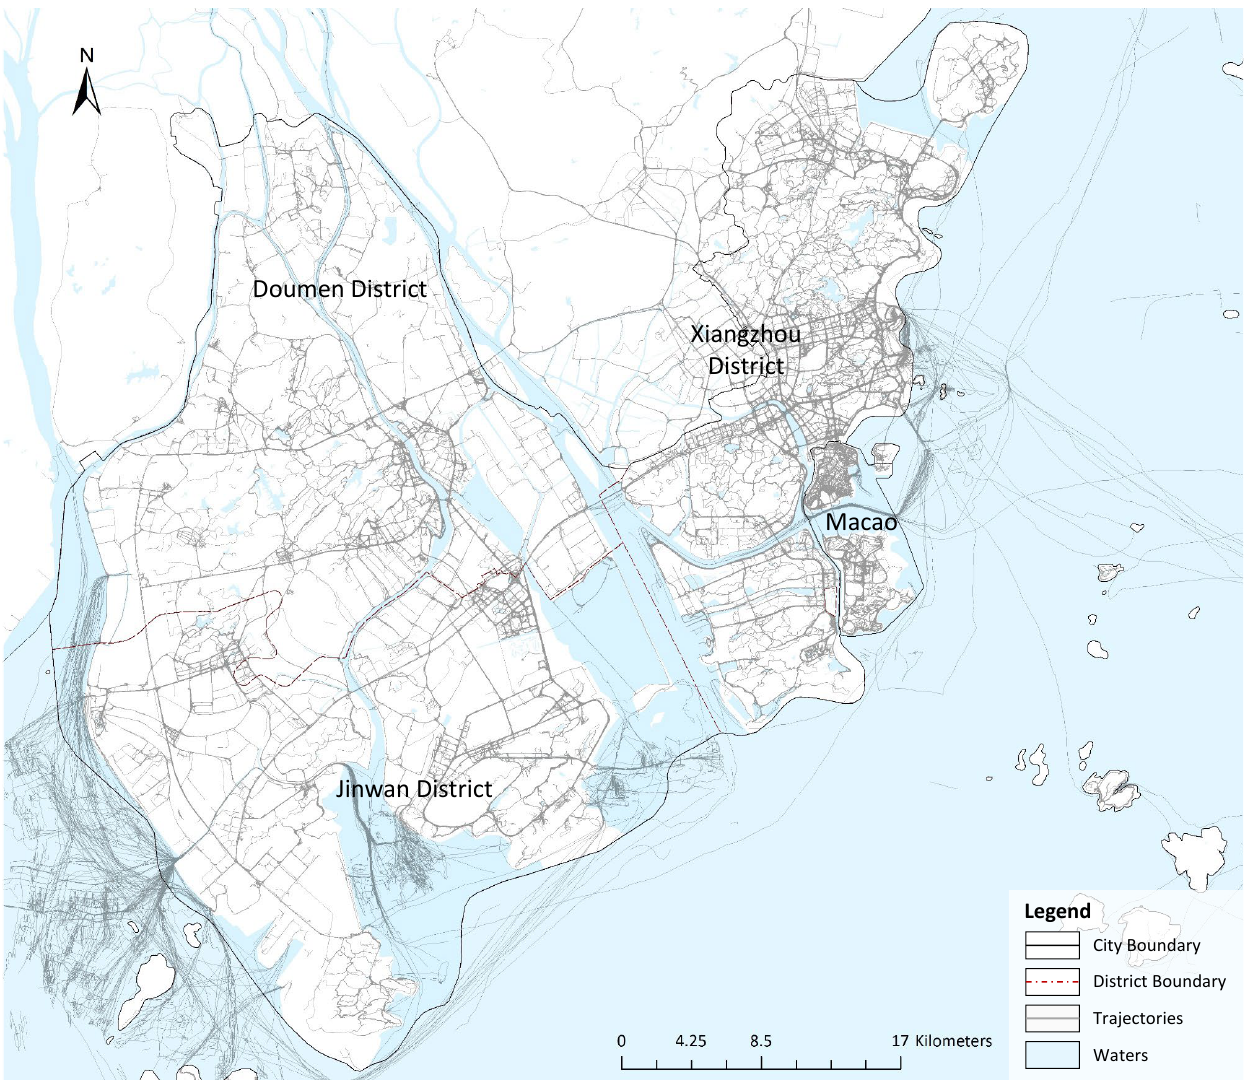
Figure 4. Trajectories in the Zhuhai–Macao metropolitan area.